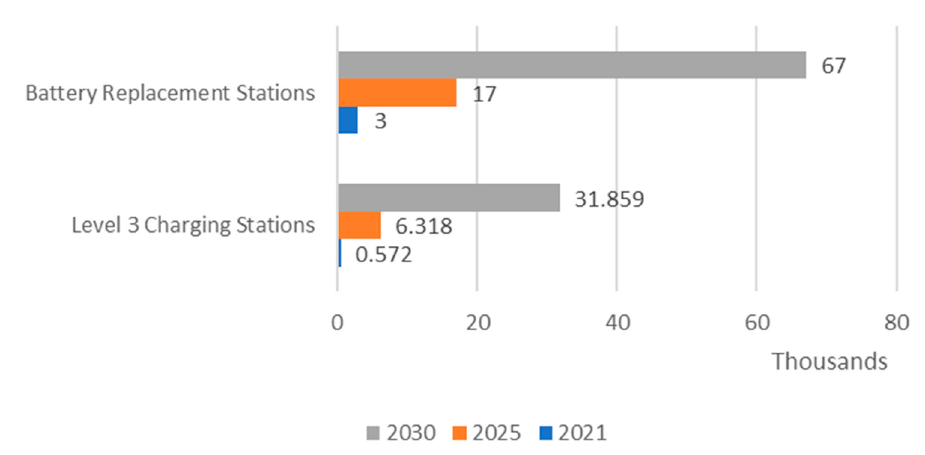
Figure 9. Roadmap of battery replacement and Level 3 charging stations made by KESDM.